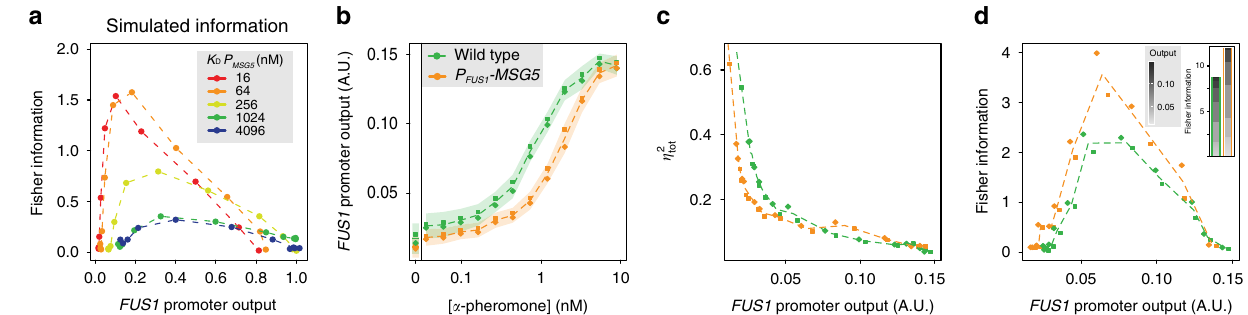
Fig. 3 Sensitized MSG5 induction leads to improved input estimation. a Dependence of simulated Fisher information on sensitivity of MSG5 feedback induction, altered by adjusting the parameter de fi ning binding af fi nity of active Ste12-P to the MSG5 promoter ( K D P MSG5 ). For simulation of the wild type in Fig. 2, K D was 700 nM. b – d Effect of sensitized MSG5 feedback induction on dose dependence of the pathway response ( b ), noise ( c ) and Fisher information ( d ). MSG5 induction was sensitized by replacing its native promoter with P FUS1 promoter that responds with higher sensitivity to pheromone. Data were acquired between 110 and 170 min after pheromone addition in two independent experiments (shown with different symbols in b – d ). Dashed lines serve as guides to the eye and connect means for both experiments; shaded areas in b centred on those lines show cell-to-cell variabilities (s.d.) across the cell populations, again averaged over both experiments. Similar results were observed when MSG5 induction was sensitized using other promoters (Supplementary Fig. 6). Inset in d shows aggregated Fisher information calculated with means for both